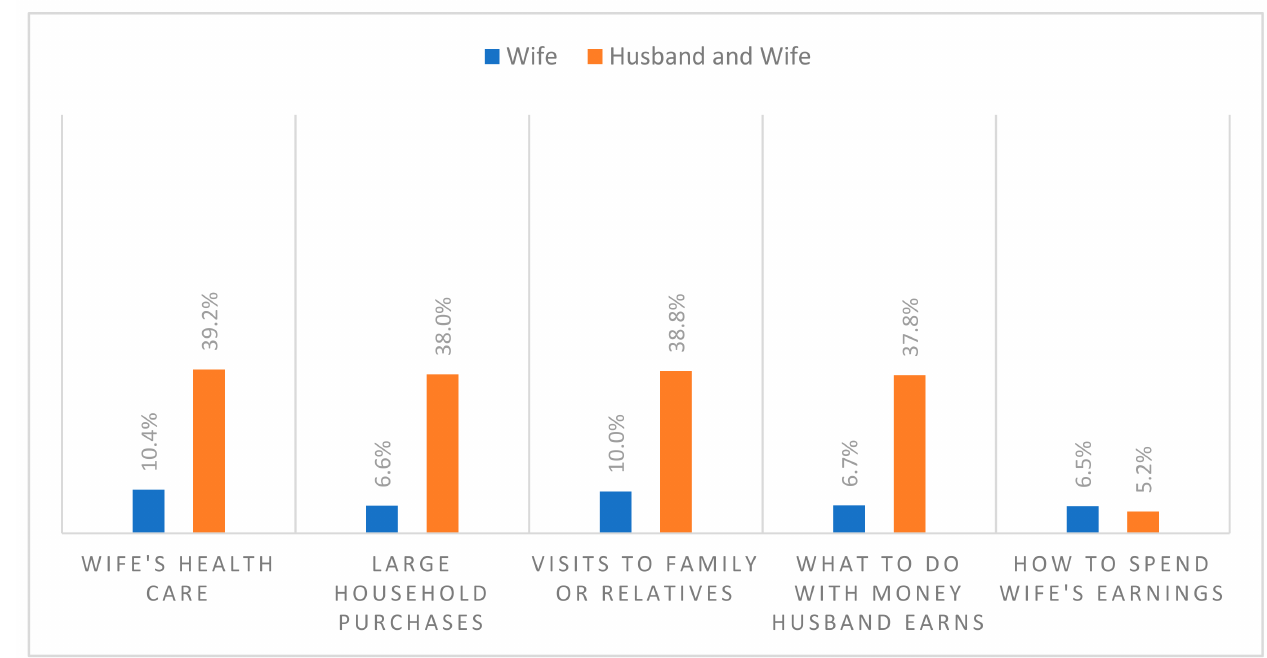
Figure 1. Women’s participation in decision making.